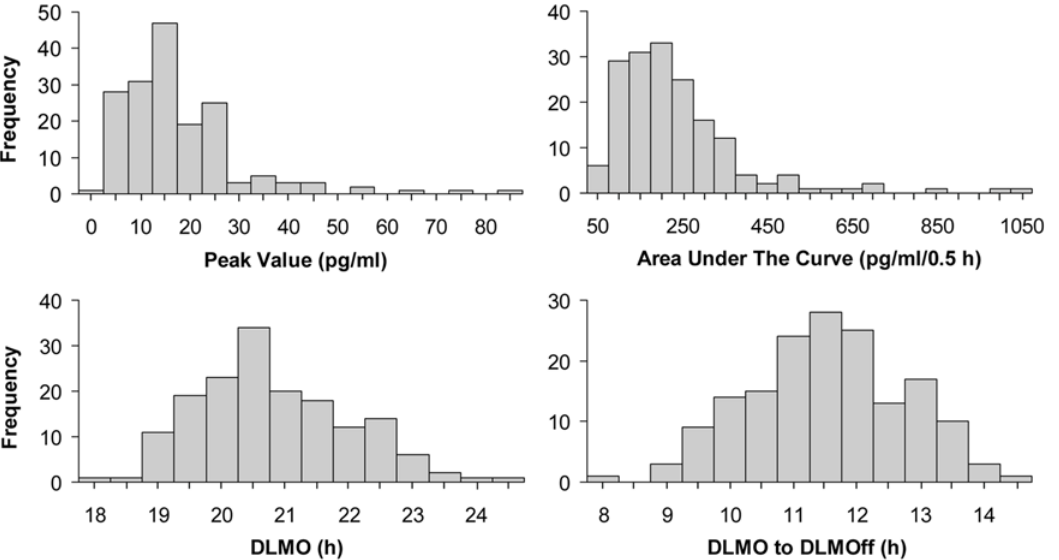
Figure 2. The frequency distributions of peak value, area under the curve, time of the DLMO and melatonin duration (DLMO- DLMOff). The frequency distributions of peak value and area under the curve were positively skewed, while DLMO and DLMO-DLMOff were normally distributed.